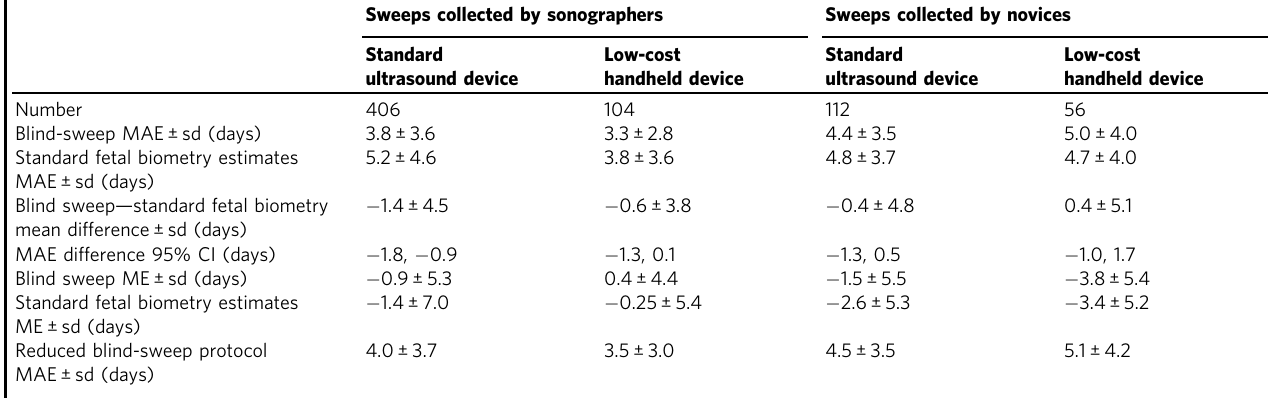
Table 1 Gestational age